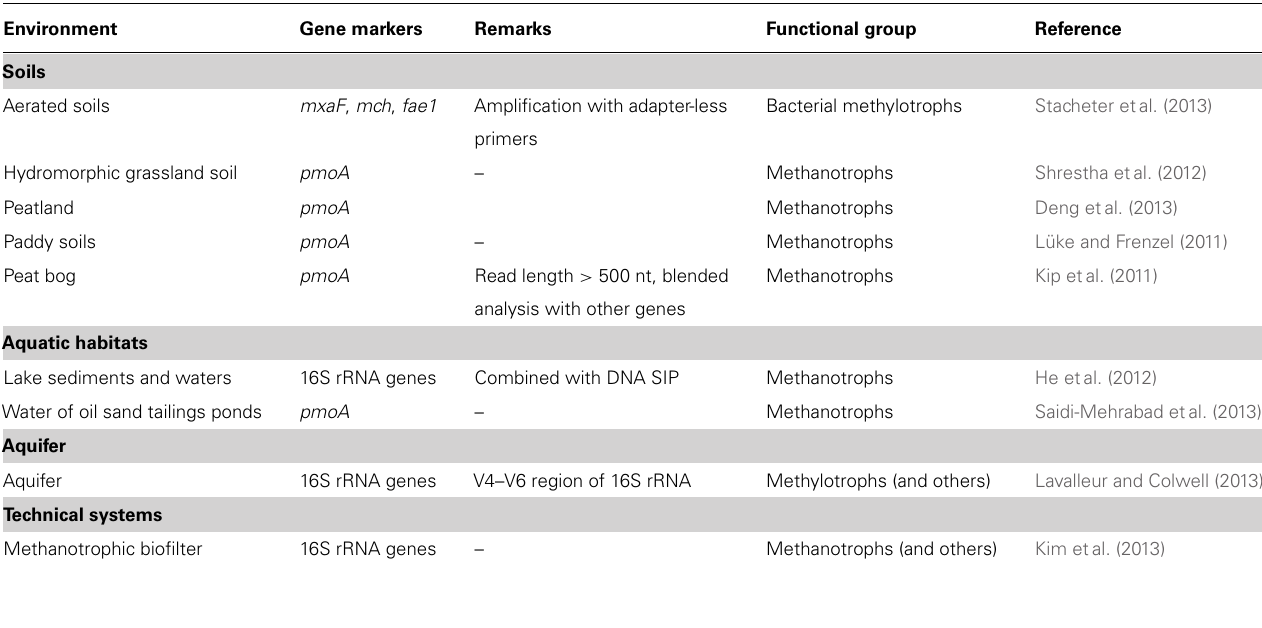
Table 4 | Use of amplicon pyrosequencing to analyze methylotrophic